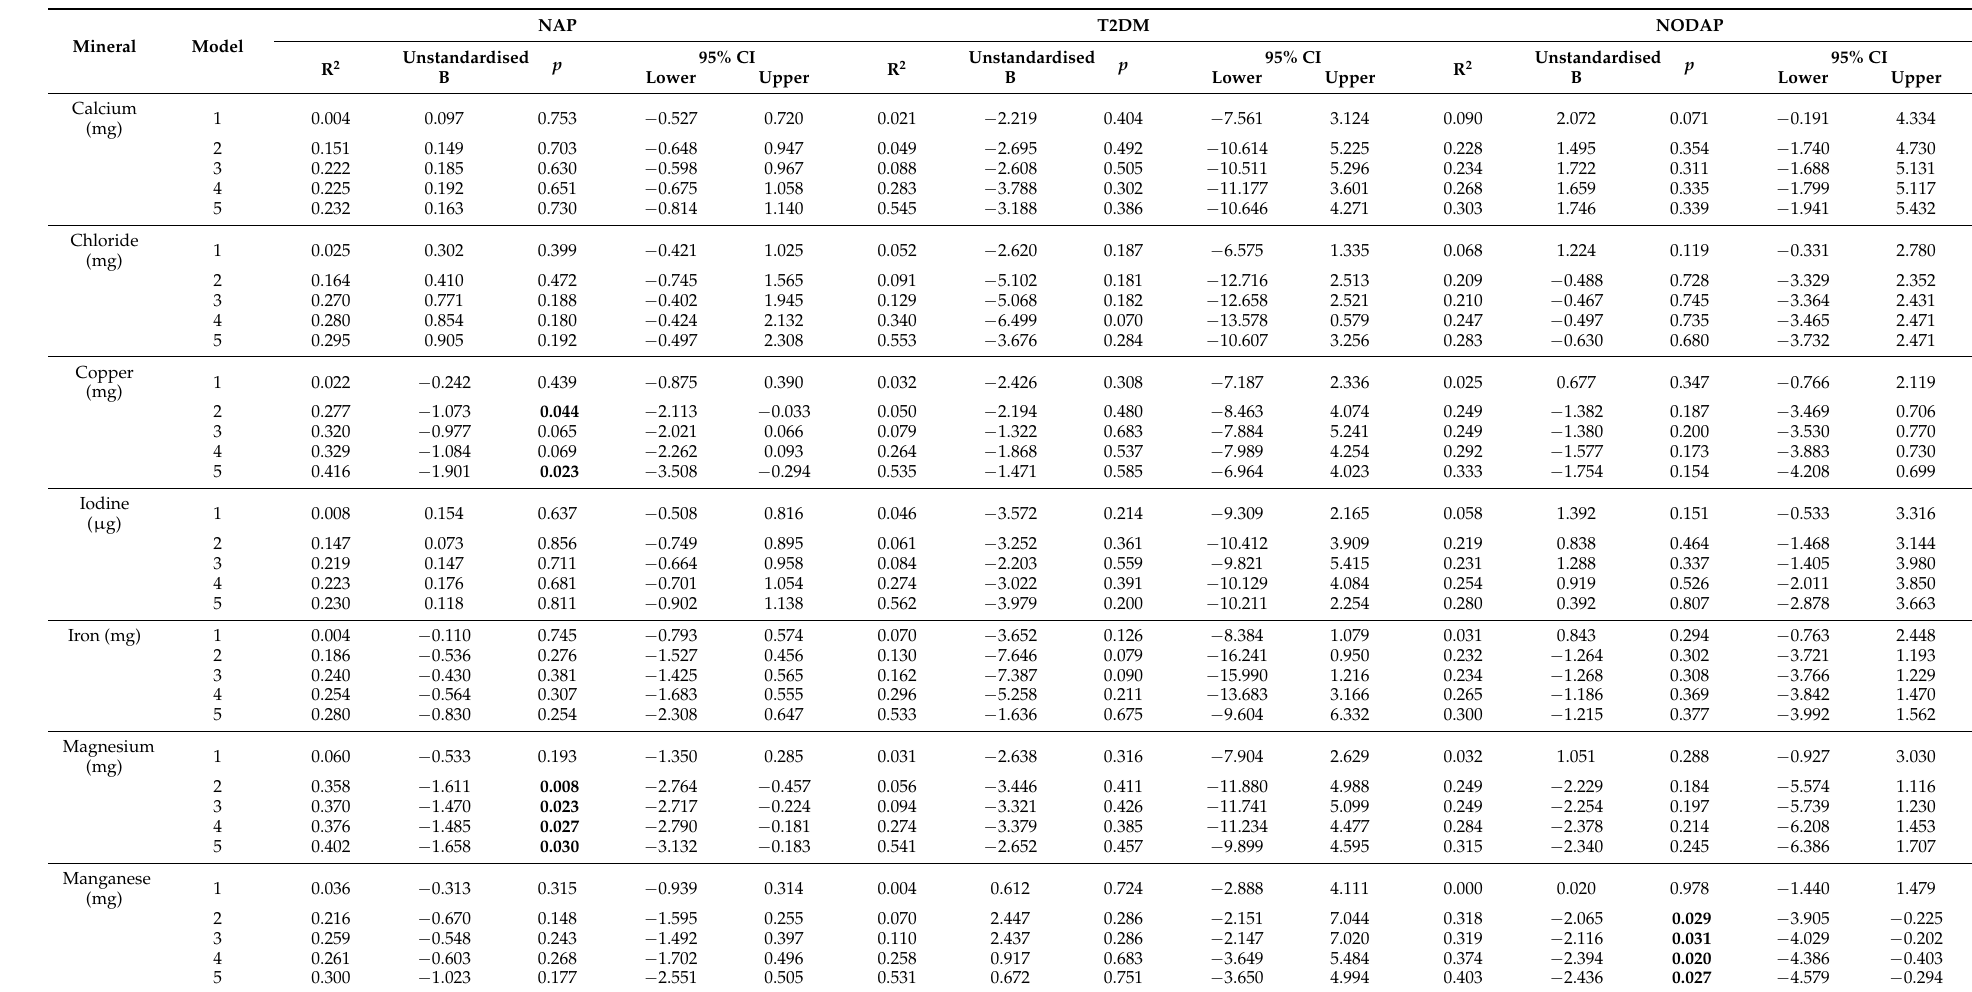
Table 4. Associations between habitual mineral intake and fasting plasma glucose in the study